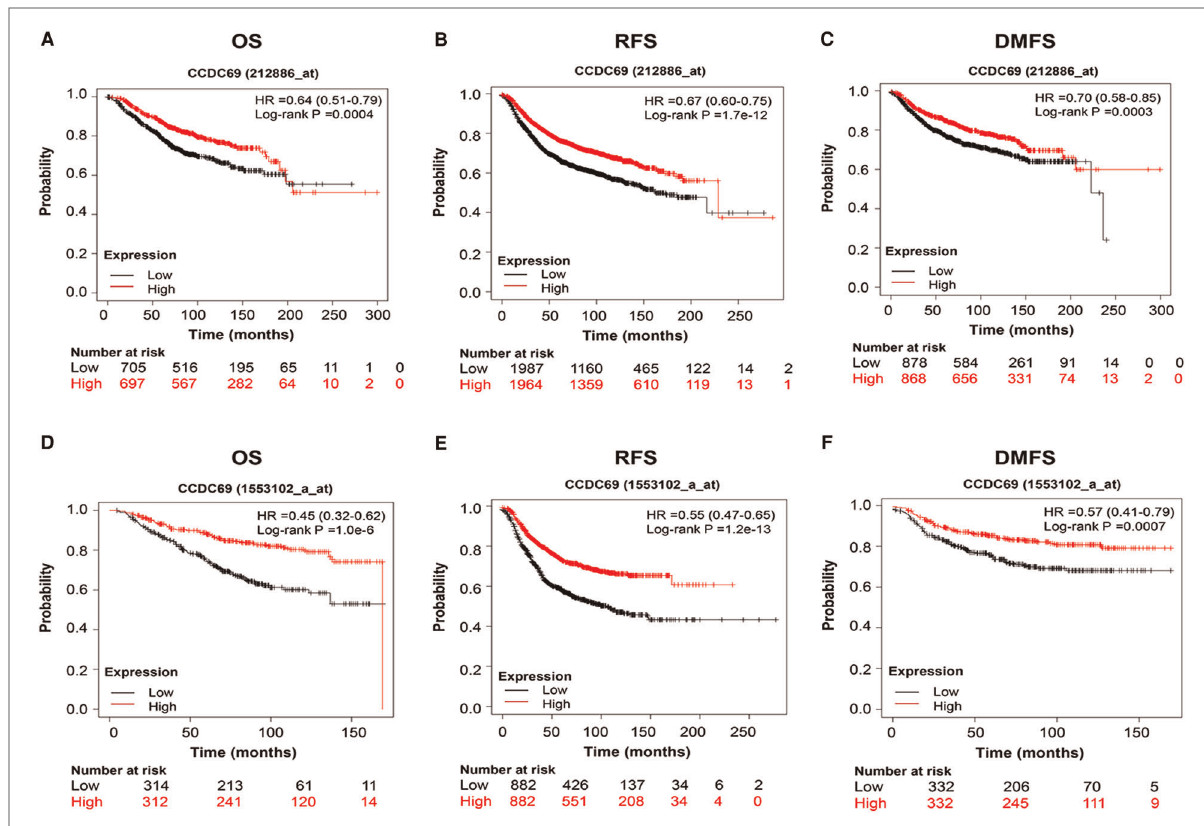
FIGURE 3 Prognostic value of CCDC69 in BC patients. ( A,D ) Overall survival curve of CCDC69 for BC patients; ( B,E ) relapse free survival curve of CCDC69 for BC patients; ( C,F ) distant metastases free survival curve of CCDC69 for BC